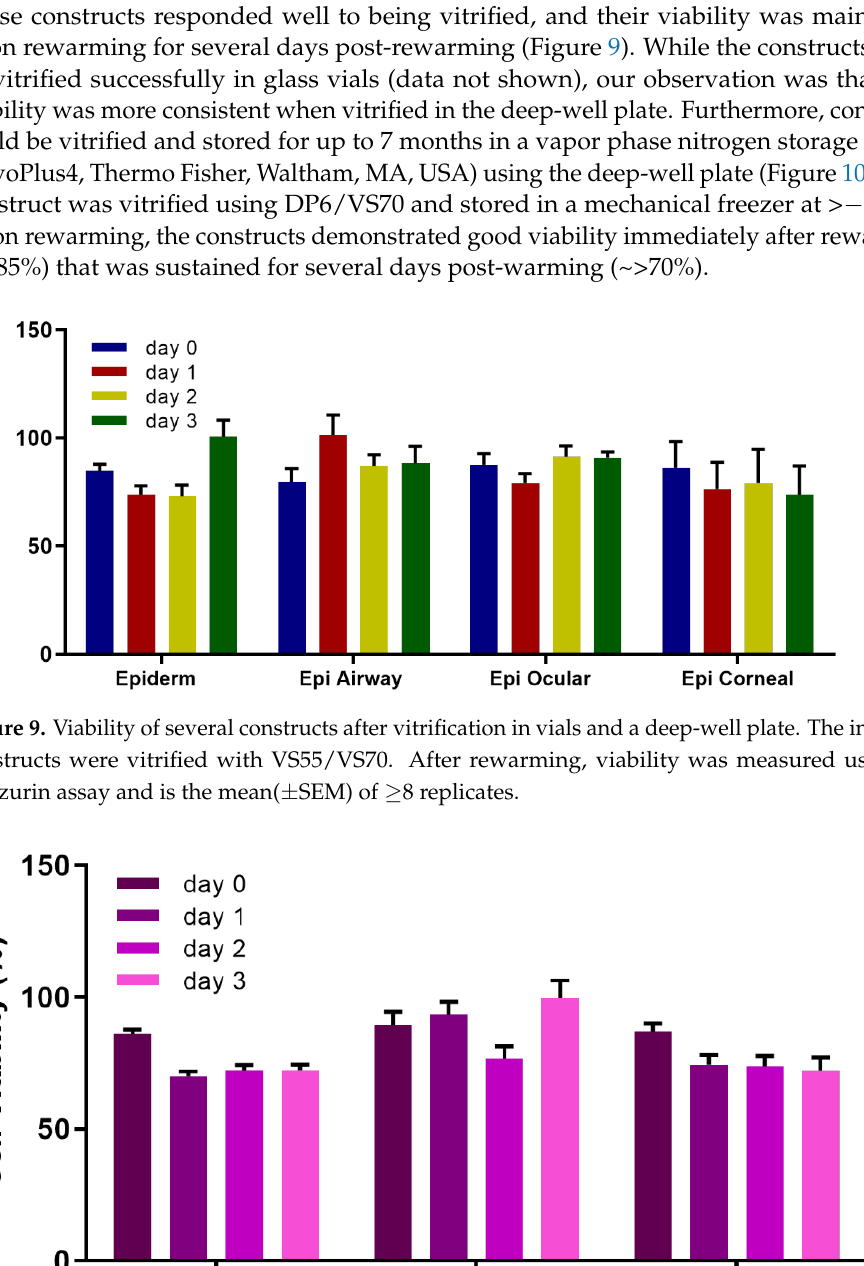
Figure 8. A full plate of EpiDerm constructs, 24, were vitrified and rewarmed using DP6/VS70. Vi- ability was measured immediately after rewarming using the resazurin assay.